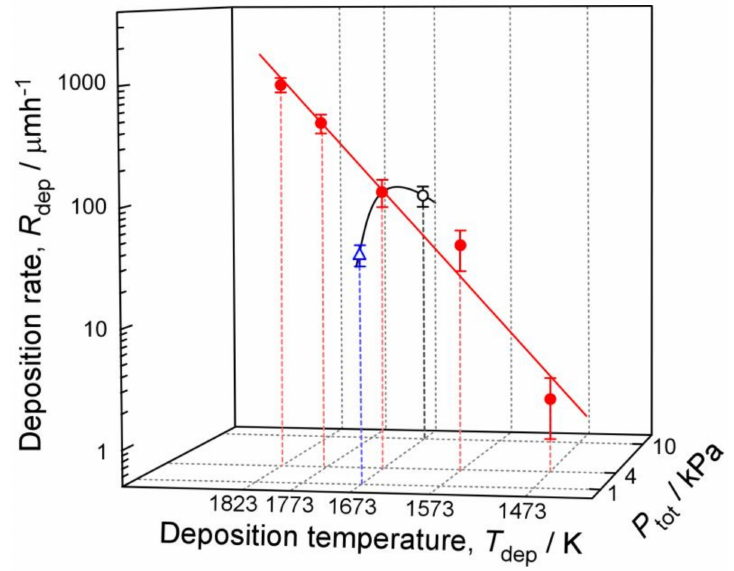
Figure 6. Effects of T dep and P tot on R dep